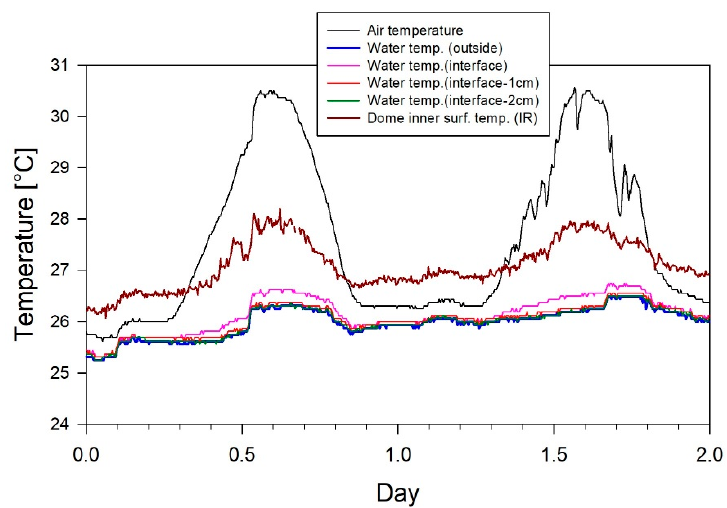
Figure 7. Measured air, inner surface, and water temperature inside the underwater biosphere.